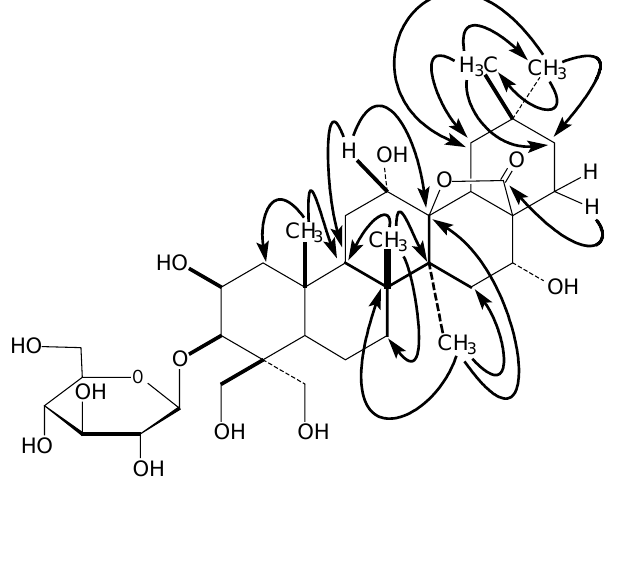
Figure 3 . Key correlations in the HMBC spectrum of 1